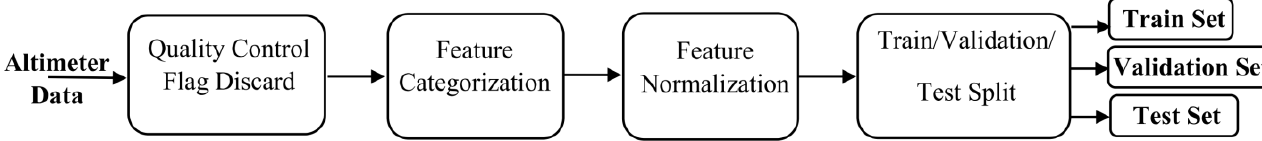
Figure 2. Preprocessing phase of the proposed framework. Table 3. Categorization of input